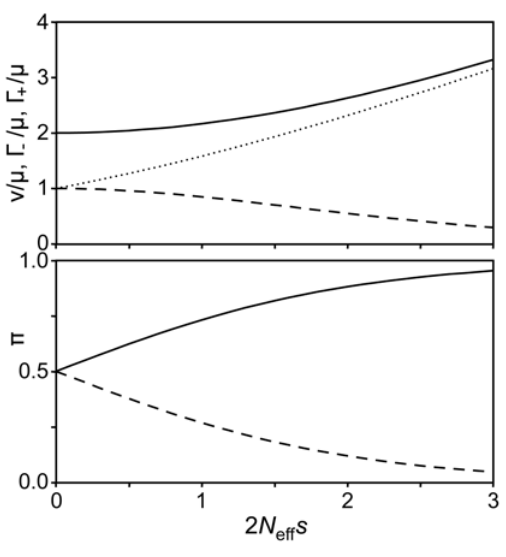
Figure 3. Changing equilibrium frequencies and rates versus selective constraints. Top: Dependence of rate scaling factor n (solid line) and rate of substitutions for adaptive (positive) selection C + (dotted line) and purifying (negative) selection C 2 (dashed line), scaled by mutation rate m , as a function of scaled selective disadvantage of residue B compared with residue A (2 N eff s ). Bottom: Equilibrium frequencies p A of A (solid line) and p B of B (dashed line) as a function of scaled selective